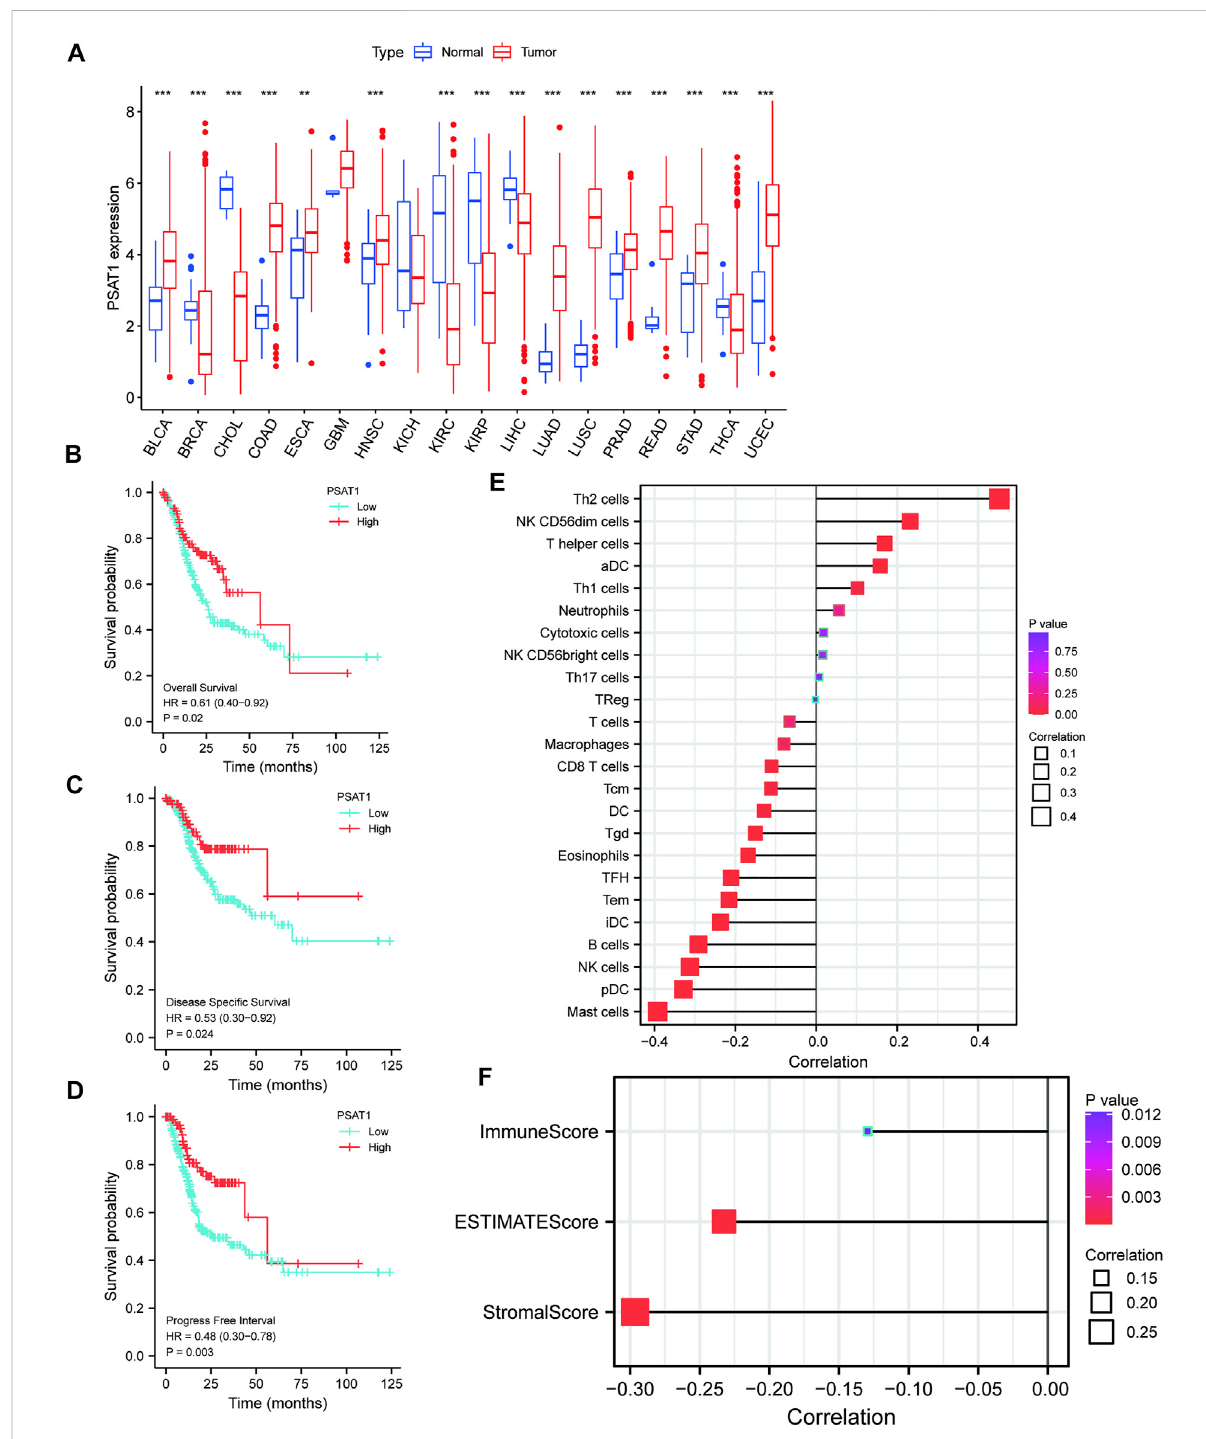
FIGURE 1 A correlation between PSAT1 expression levels and cancer patient prognosis. (A) . Box plot showing the level of PSAT1 mRNA expression in different cancer tissues and normal tissues; data from UCSC database; *** p < 0.001, ** p < 0.01; (B) . Survival analysis demonstrating the overall survival of gastric cancer patients with high PSAT1 expression (OS, HR = 0.61, 95% CI: 0.40 – 0.92, p = 0.02); (C) . Survival analysis demonstrating the relationship between PSAT1 expression levels and DSS of gastric cancer patients (DSS, HR= 0.53, 95% CI: 0.30 – 0.92, p = 0.024); (D) . Survival analysisdemonstratingtherelationshipbetweenPSAT1expressionlevelsandprogress-freeintervalofgastriccancerpatients(PFI,HR=0.48,95%CI: 0.30 – 0.78, p = 0.003); (E) . Correlation analysis of PSAT1 expression with immune cell in fi ltration displaying that TH2 cells and NK cells are positively correlated with PSAT1, whereas plasmacytoid dendritic cells and mast cells are negatively correlated with PSAT1; (F) . PSAT1 correlation analysis with ImmuneScore, StromalScore, and